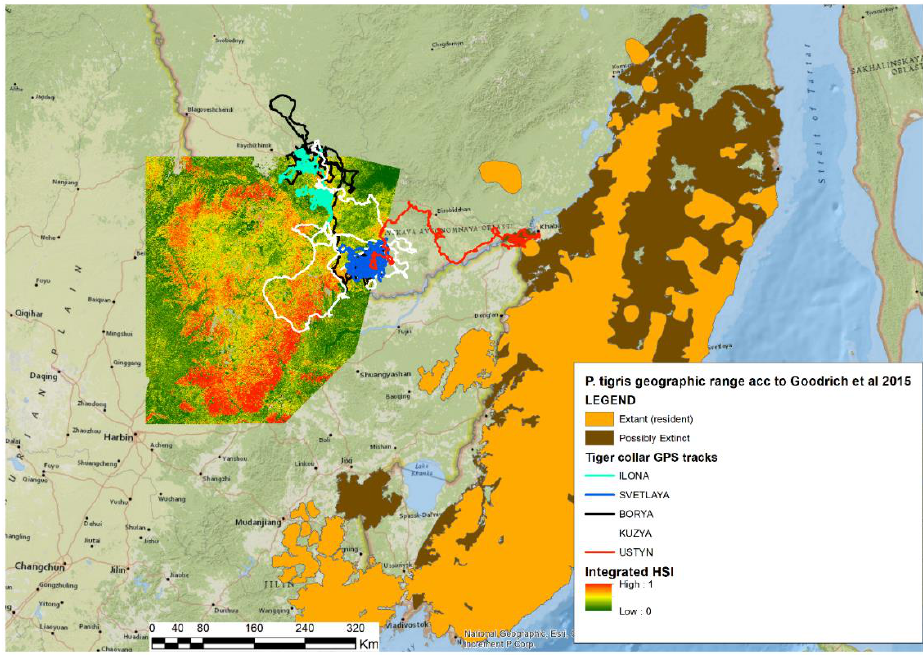
Figure A4. Tiger geographic range [1], integrated with our resulting prey-based HSI model and with pure GPS tracks received from reintroduced tigers’ collars.